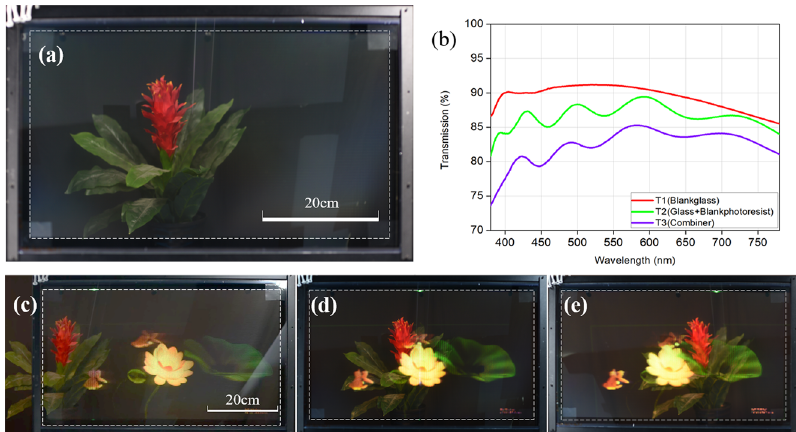
Figure 5: (a) Photo of the holographic see- through combiner with a bromeliad placed behind. The white dots illustrates the area that covered with metagratings. (b) Trans- mittance curves of the holographic